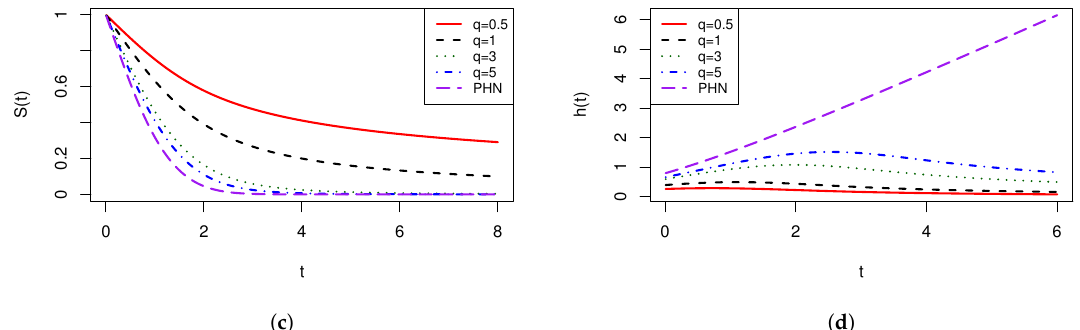
Figure A2. SPHN ( 1, α = 1, q ) = SHN ( 1, q ) for different values of q . In all panels, q = 0.5 (red), q = 1 (black), q = 3 (green), q = 5 (blue), and q = ∞ (purple). ( a ) pdf of SPHN ( 1, α = 1, q ) . ( b ) cdf of SPHN ( 1, α = 1, q ) . ( c ) Survival function of SPHN ( 1, α = 1, q ) . ( d ) hazard rate function of SPHN ( 1, α = 1, q ) .